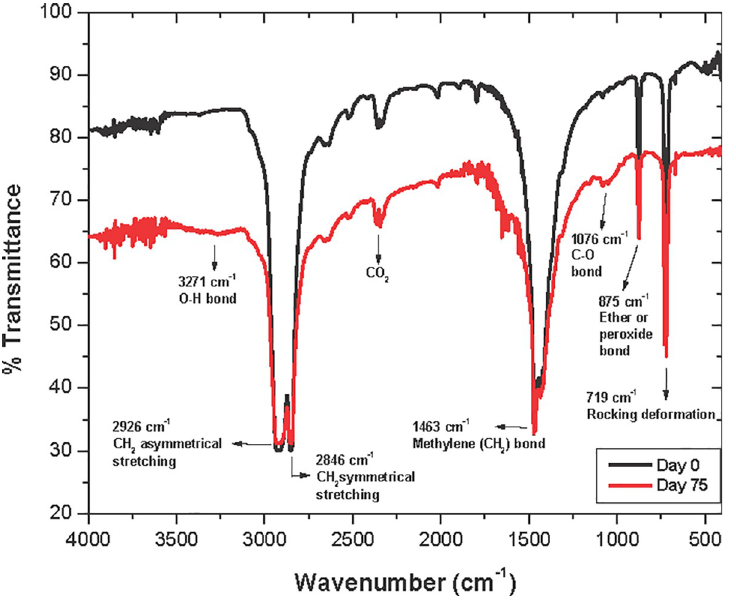
Fig 3. FTIR analysis for plasma treated LDPE oxo sheets before incubation at day 0 (black line) and after 75 days of incubation in microcosm system (day 75: red line).